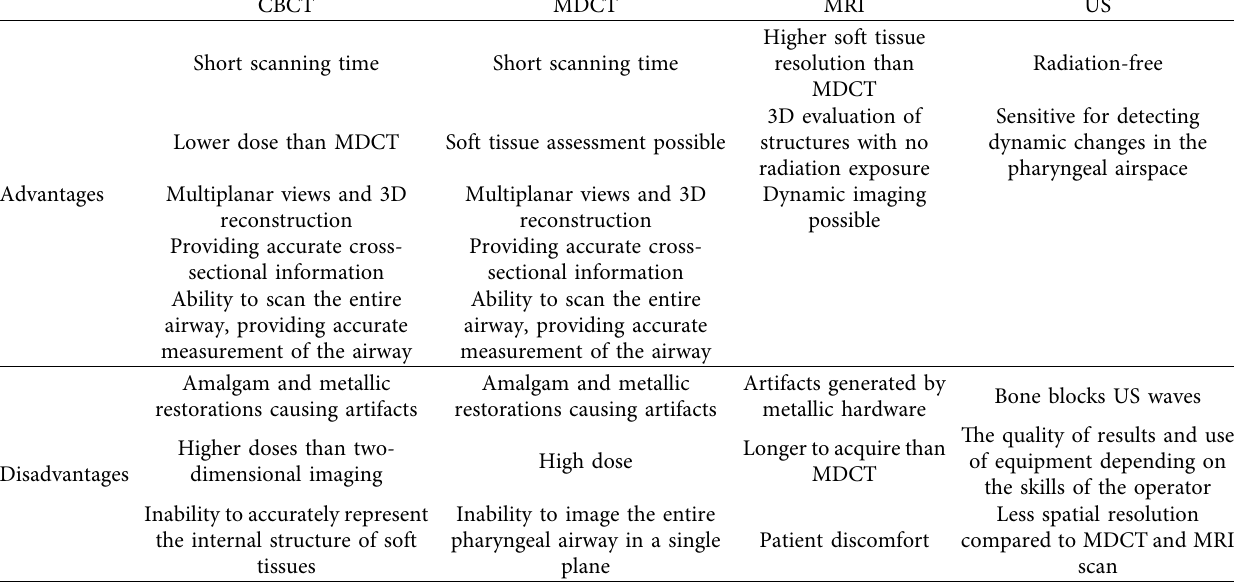
Table 1: Advantages and disadvantages of imaging techniques used in the diagnosis of